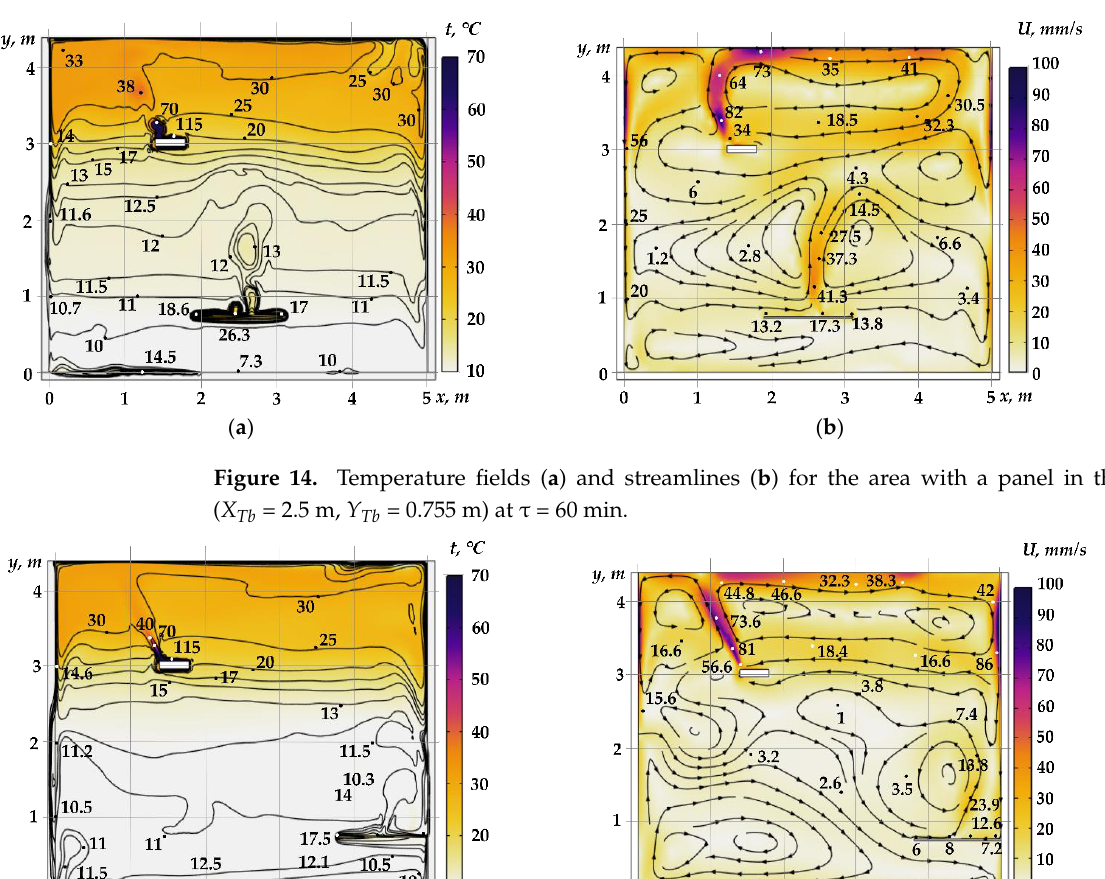
Figure 13. Temperature fields ( a ) and streamlines ( b ) for the area with the panel near the left wall ( X Tb = 0.6 m, Y Tb = 0.755 m) at τ = 60 min.